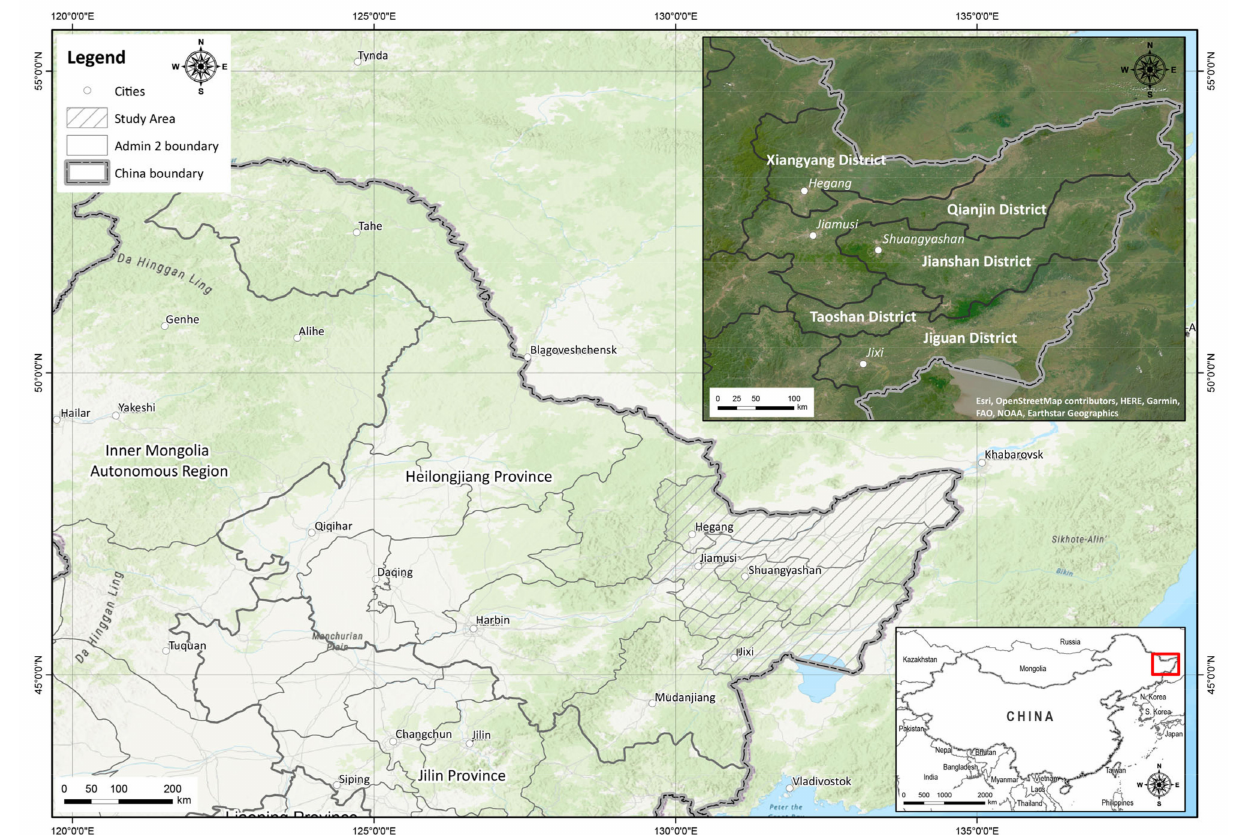
Figure 1. Study area map showing the Xiangyang, Qianjin, Jianshan, Taoshan, and Jiguan Districts in the southeastern Heilongjiang Province of